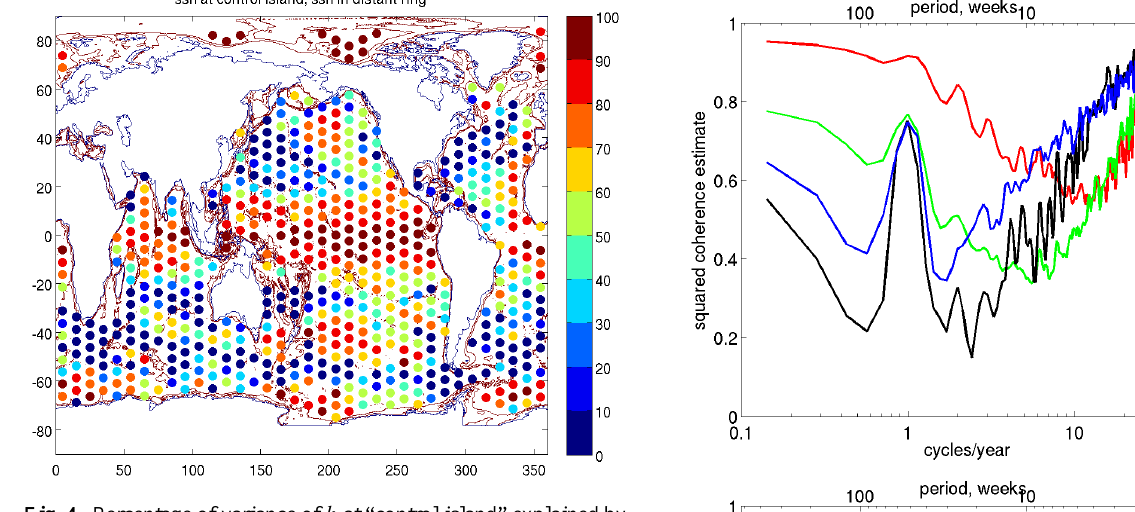
Fig. 4. Percentage of variance of h at “control island” explained by h in a 5 ◦ diameter ring.